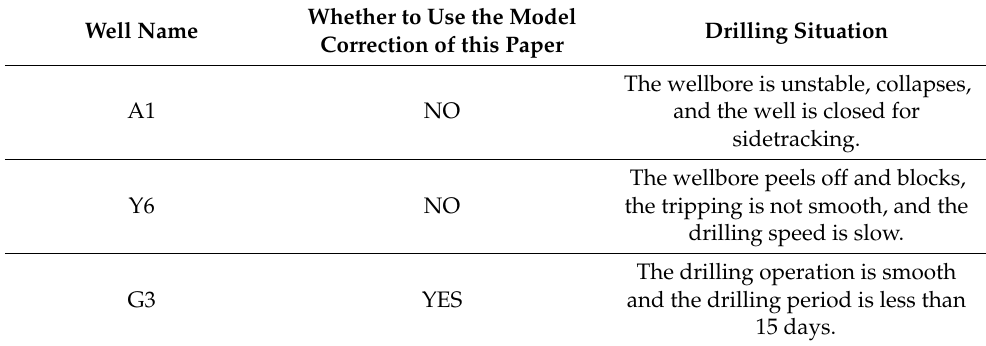
Table 2. Adjustment of drilling fluid